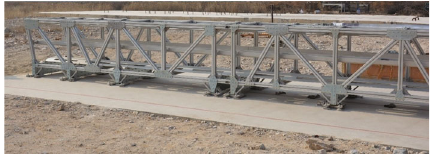
Figure 15: Ground ejection test site. Table 2: Missile derailment speed simulation and test results.